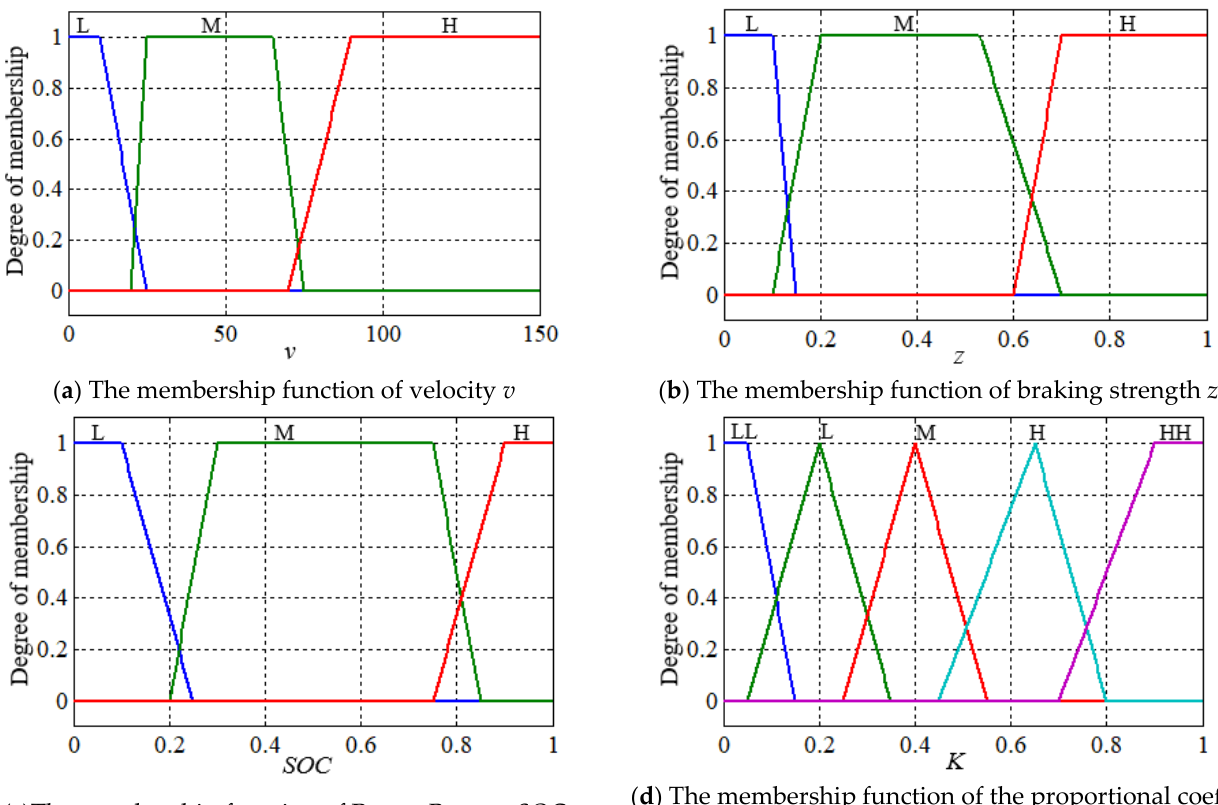
Figure 9. Input and output variable membership functions.